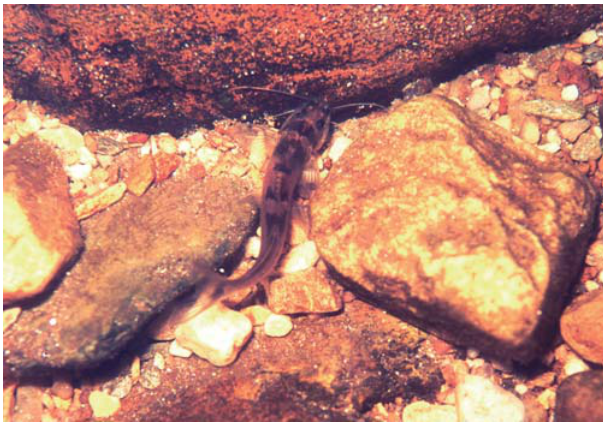
Fig. 7. Imparfinis minutus specimen sheltering itself from cur- rent among rocks in the riffles bottom, during daytime (photo: Ricardo M.C.